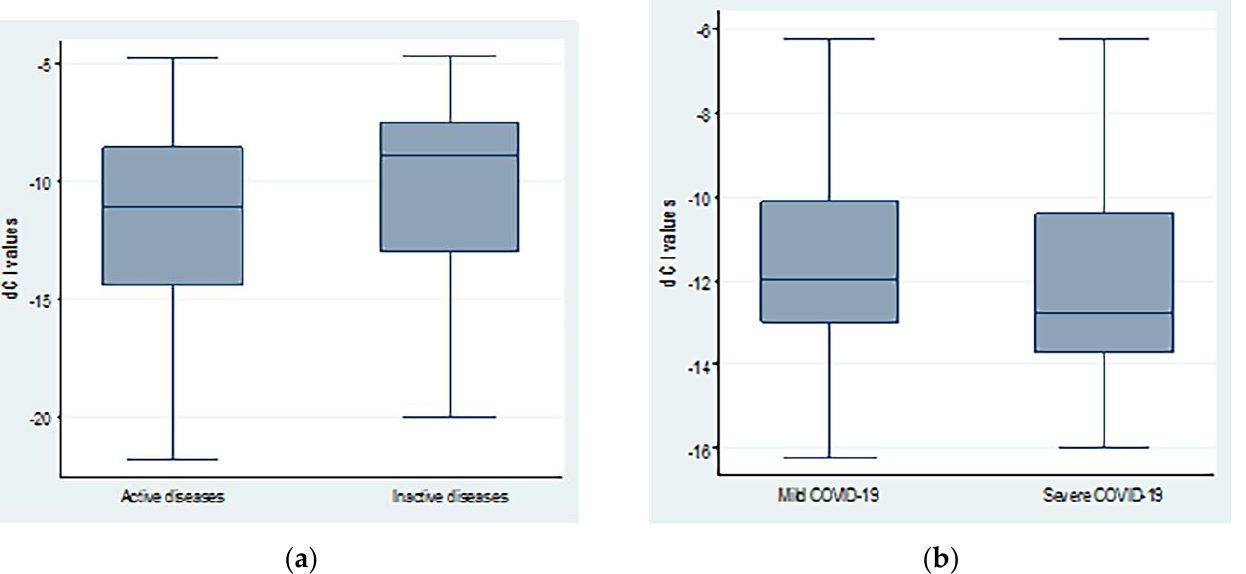
Figure 2. dCt (CtTBP−CtsjTREC) values regarding ( a ) autoimmune diseases activity and ( b ) COVID ‒ 19 severity.